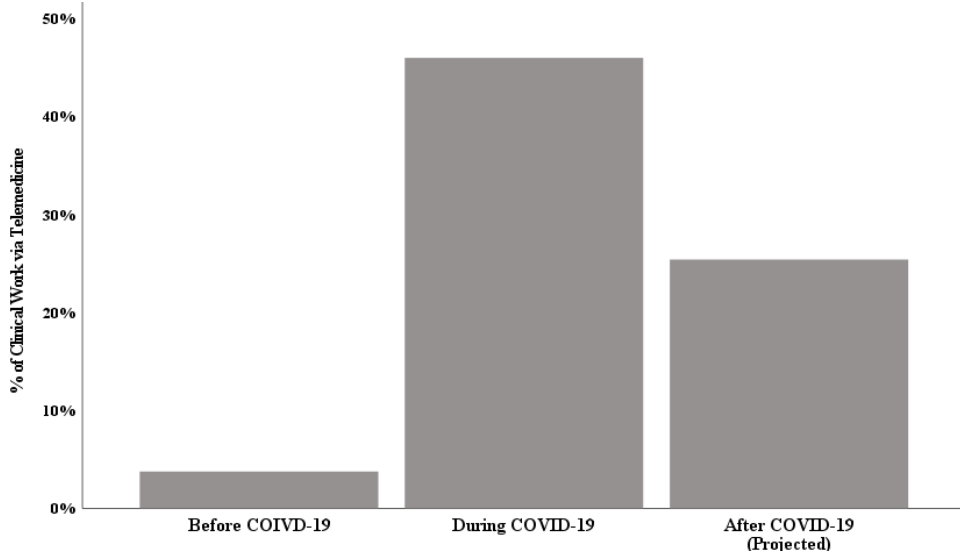
Figure 1. Estimated percentage of clinical work performed via telemedicine before, during, and after (projected) the COVID-19 pandemic.